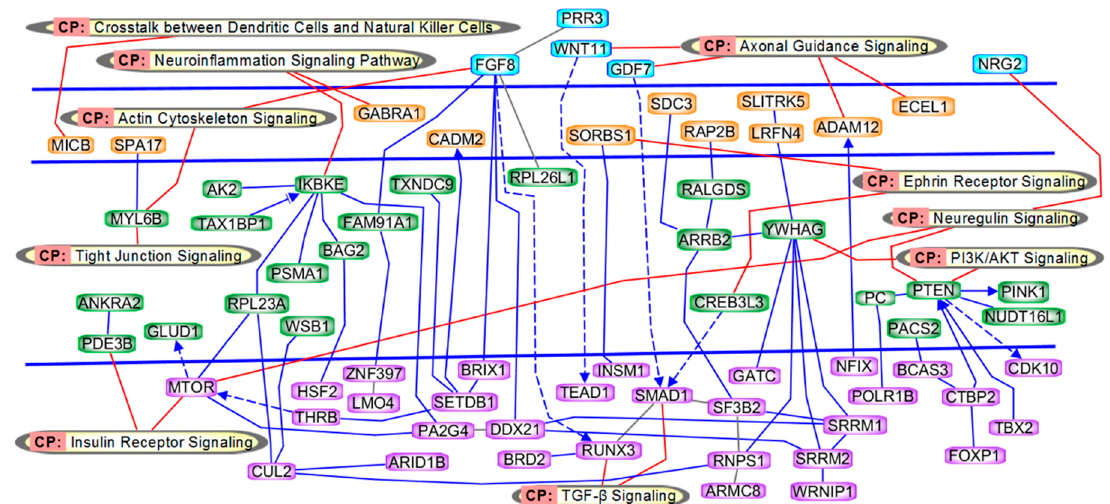
Figure 3. Ingenuity pathway analysis (IPA) results for 258 gene pathways included in the analysis. These genes were most highly differentially-methylated in association with CP. IPA results indicated the gene network are related to CP development, including: neuromotor damage, malformation of major brain structures, brain growth, neuroprotection, neuronal development and dedifferentiation, and cranial sensory neuron development.